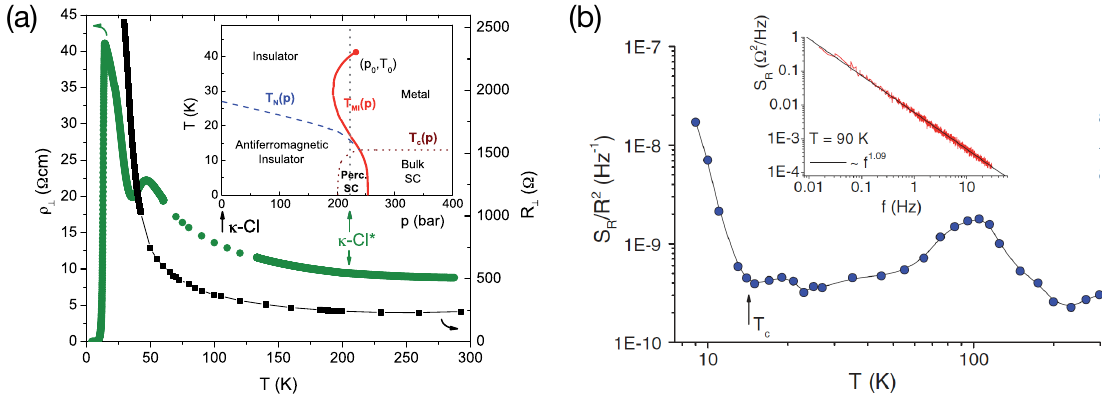
FIG. 2 (color online). Temperature dependence of the normal- FIG. 1 (color online). Resistivity (resistance) of two samples ized resistance noise at 1 Hz of ! - Cl " . Arrows indicate the Figure 5. Noise at the percolative superconducting transition. ( a ) resistance of two samples of Cu N CN Cl . The inset shows a schematic phase of ! - ET superconducting transition (onset of T c ) and the temperature of ½ ð Þ 2 ’ ð Þ 2 κ -(ET) 2 Cu[N(CN) 2 ]Cl. Inset shows a schematic phase diagram, cf. Figures2 and 10b. Arrows indicate diagram after [8,10,12,13,16]. T N and T c denote the Ne´el and reentering the insulating phase. Inset: PSD of the resistance superconducting transition temperatures, respectively. Arrows noise at 90 K in a log-log plot. The line is a linear fit yielding the positions of the samples measured at ambient conditions ( κ -Cl) and at a finite pressure ( κ -Cl ∗ ); 1 =f 1 : 09 . Also shown are two spectra taken at 60 K; the indicate the positions of the samples measured at ambient S R ( b ) normalized resistance noise PSD S R / R 2 ( T , f = 1Hz ) of κ -Cl ∗ . Arrow indicates the superconducting / temperature has been swept in between these measurements. conditions ( ! - Cl ) and at a finite pressure ( ! - Cl " ). transition (onset of T c ). Inset: PSD of the resistance noise at 90K in a log-log plot revealing a clean S R ∝ 1/ f α spectrum with α = 1.09. Reprinted with permission from [68]. Copyright (2009) by